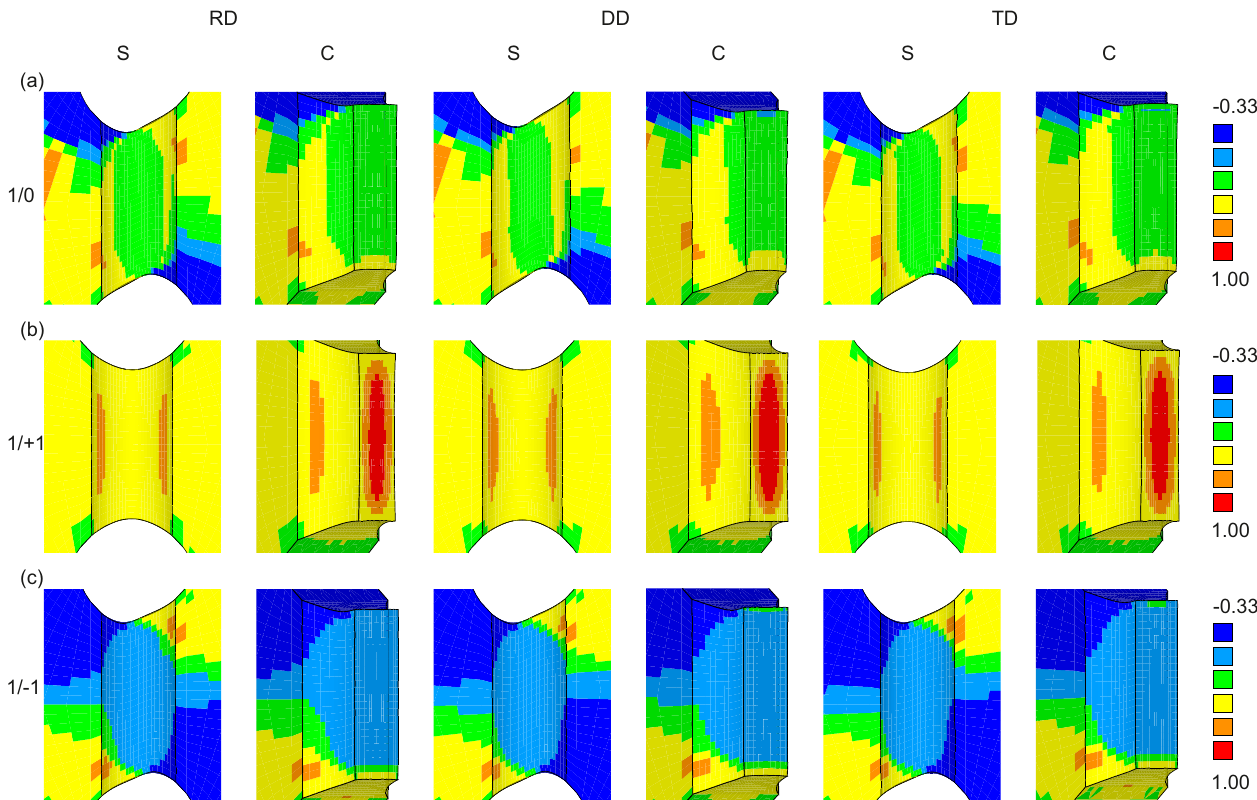
Figure 11. Stress triaxialities η for the load ratios ( a ) F 1 / F 2 = 1/0, ( b ) F 1 / F 2 = 1/+1 and ( c ) F 1 / F 2 = 1/ −